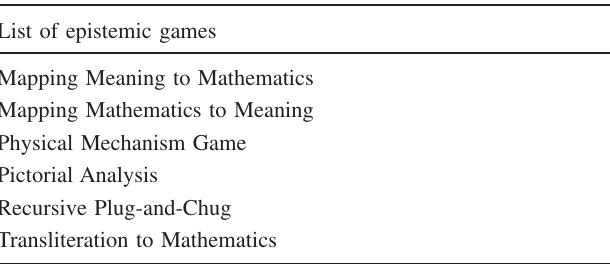
TABLE II. List of epistemic games identified in our data set.